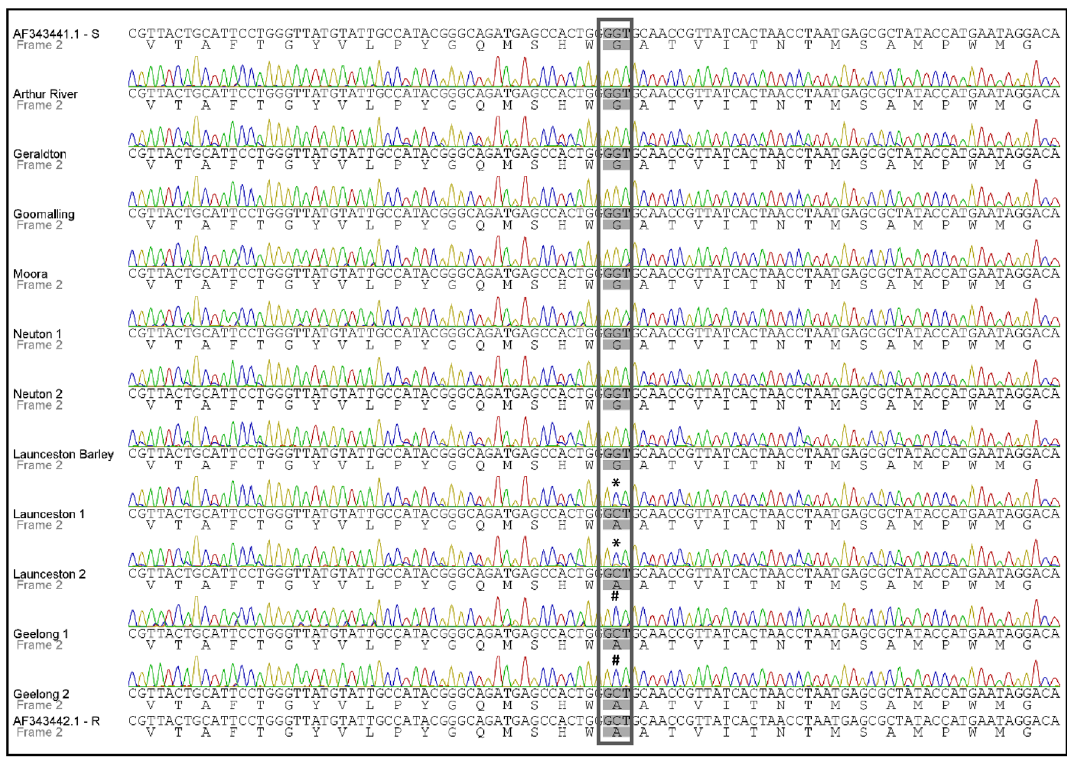
Figure 1. Multiple sequence alignment of the cytb gene sequence and its translation (yeast mitochondrial translation table_3) flanking the g428c mutation for samples collected in 2016 (Table 1). AF343441.1 and AF343442.1 correspond to strobilurin sensitive and resistant Bgt cytb reference sequences, respectively. The samples Launceston 1 and 2, and Geelong 1 and 2 contain the substitution G143A. Codon 143 is boxed; * denotes a mix of the G and C base; # shows C base only. Arthur River, Geraldton, Goomalling and Moora— Western Australia; Neuton—South Australia; Launceston—Tasmania; Geelong—Victoria.